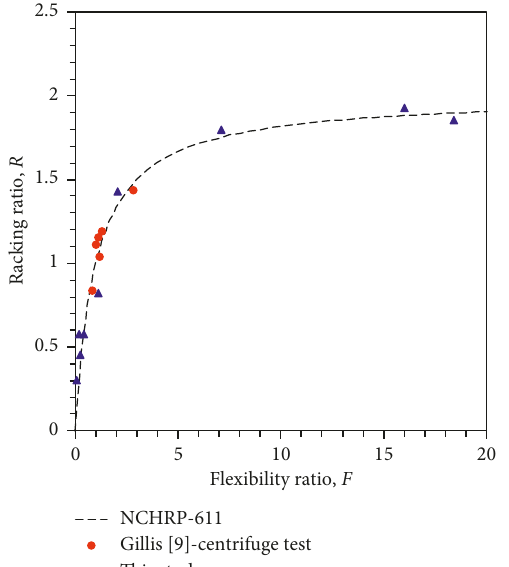
Figure 12: Comparison of racking and flexibility ratio ( F-R ) relationship NCHRP-611 report [32] and centrifuge tests of Gillis